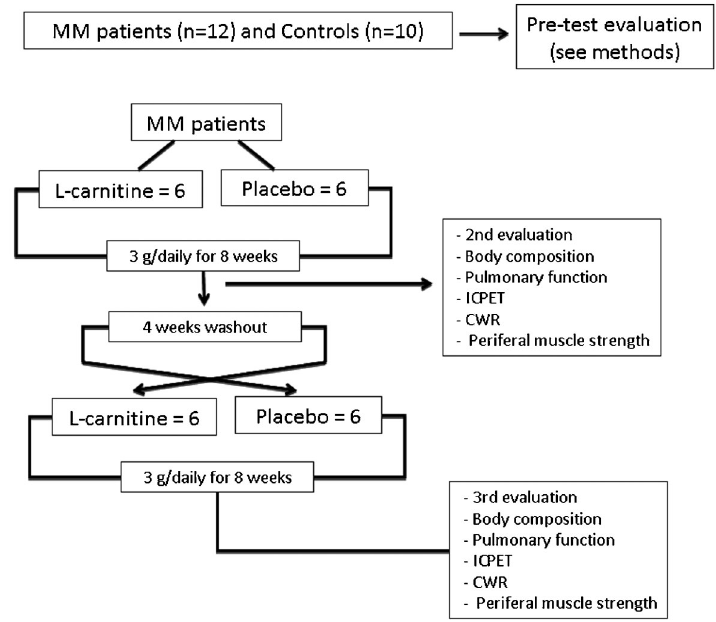
Figure 1. Design of study protocol. MM: mitochondrial myopathy; ICPET: incremental cardiopulmonary exercise test; CWR: constant work